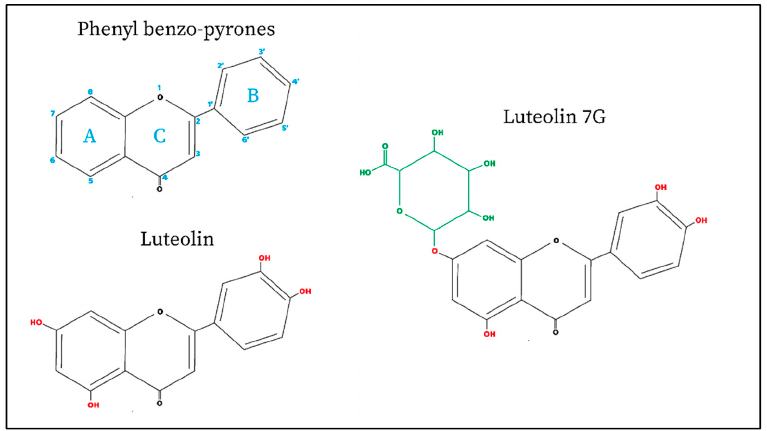
Figure 3. Basic chemical structure and molecular geometry of phenyl benzo-pyrones, luteolin (3 ′ ,4 ′ ,5 ′ ,7 ′ -tetrahydroxy flavone), and